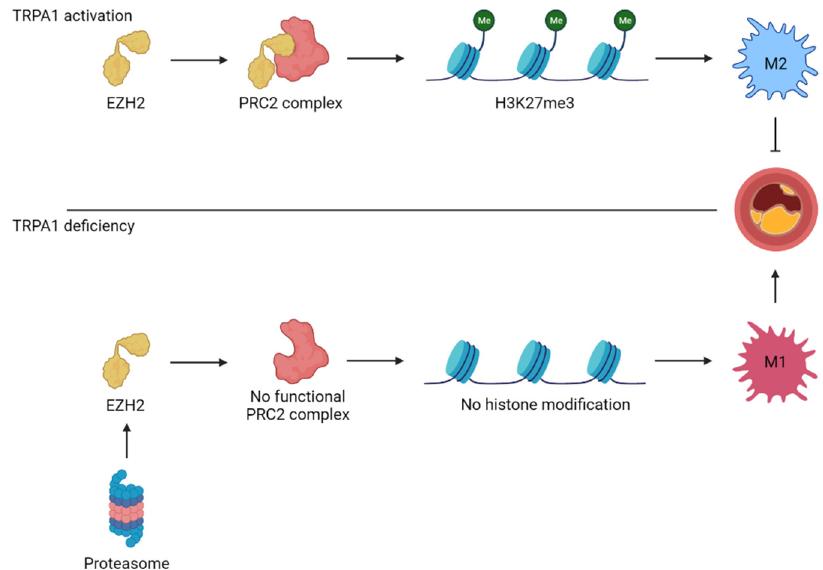
Figure 2. TRPA1 controls the polarization state of macrophages through histone modifications. TRPA1 protects EZH2, one of four subunits of the polycomb repressive complex 2 (PRC2), against proteasomal degradation. The functional PRC2 complex tri-methylates lysine 27 on histone protein 3 (H3K27me3), resulting in closed chromatin and suppression of M1 macrophage-polarizing genes. This shifts the macrophage towards an M2 phenotype and protects against atherosclerotic progression. Contrary to that, TRPA1 deficiency leads to EZH2 degradation and open chromatin. This differentiates macrophages into M1 macrophages and facilitates atherosclerotic progression.